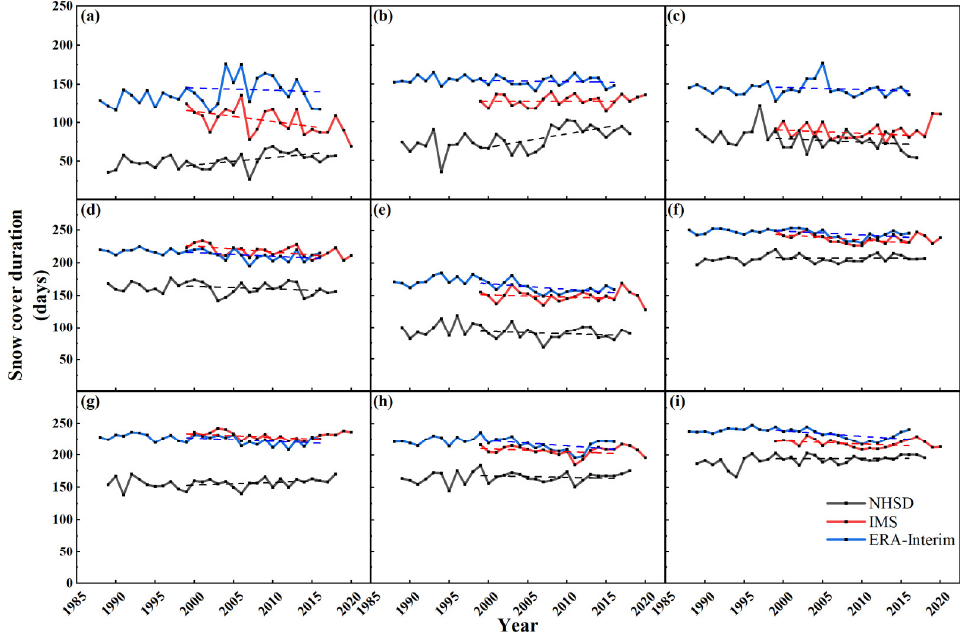
Figure A4. Comparison of the SCD derived from NHSD, IMS, and ERA-Interim in typical areas. The typical areas are ( a ) the Alps, ( b ) the Rocky Mountains, ( c ) the Qinghai–Tibet Plateau, ( d ) Alaska, ( e ) the Eastern European Plain, ( f ) the Eastern Siberian Mountains, ( g ) Northern Canada, ( h ) the West Siberian Plain, and ( i ) the Central Siberian Plateau.